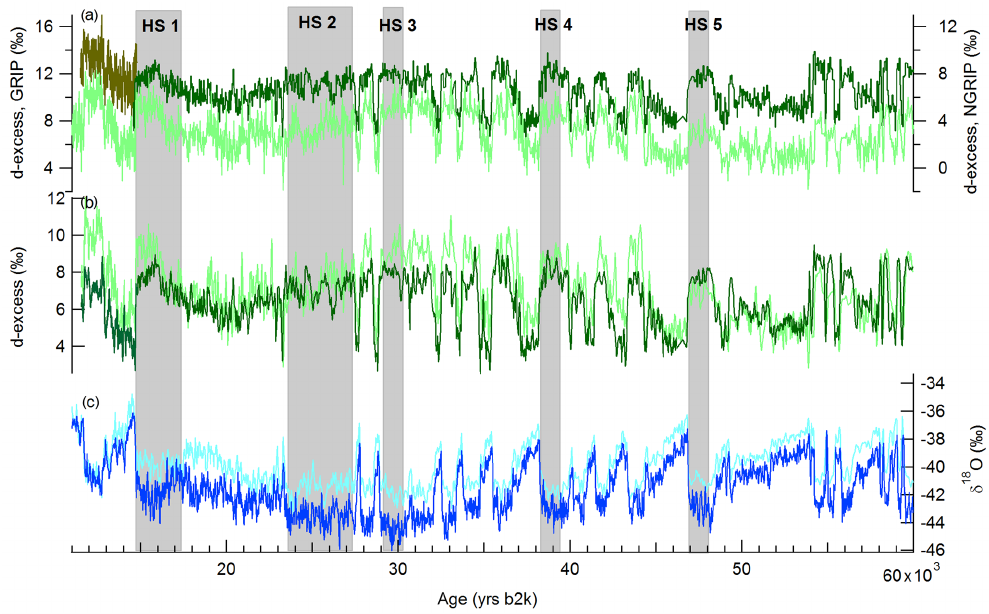
Figure 1. Water stable isotope records ( δ 18 O and d-excess, in ‰) from GRIP and NGRIP ice cores reported on the GICC05 chronology (in thousands of years before year 2000CE). (a) D-excess from the NGRIP ice core (khaki: data obtained at INSTAAR SIL, Steffensen et al., 2008; dark green: data obtained at LSCE, this study); d-excess from the GRIP ice core (light green, Masson-Delmotte et al., 2005); (b) d-excess from the NGRIP ice core after correction of the shift between the INSTAAR SIL and LSCE (dark green) datasets, and d-excess from the GRIP ice core (light green); C- δ 18 O from the NGRIP ice core (dark blue) datasets, δ 18 O from the GRIP ice core (light blue). Grey intervals display Heinrich Stadials